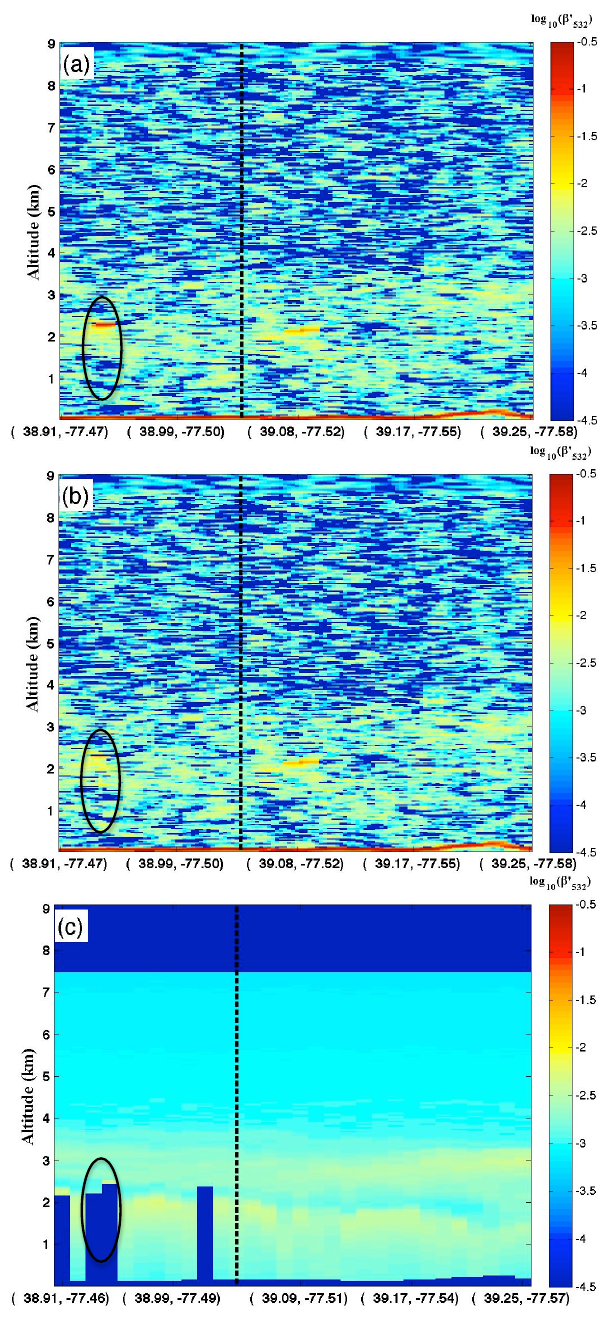
Fig. 3. 4 August 2007 – CALIOP version 2 raw (a) , CALIOP ver- sion 2 with further cloud-screening (b) and HSRL (c) β scene along the 40km segment of its ground tracks close to CATZ- Sanders (respectively white and green line in Fig. 2a). Both CALIOP and HSRL are shown at a ∼ 4/3km resolution; the black circles in (a) , (b) and (c) point out a region with cloud contamina-